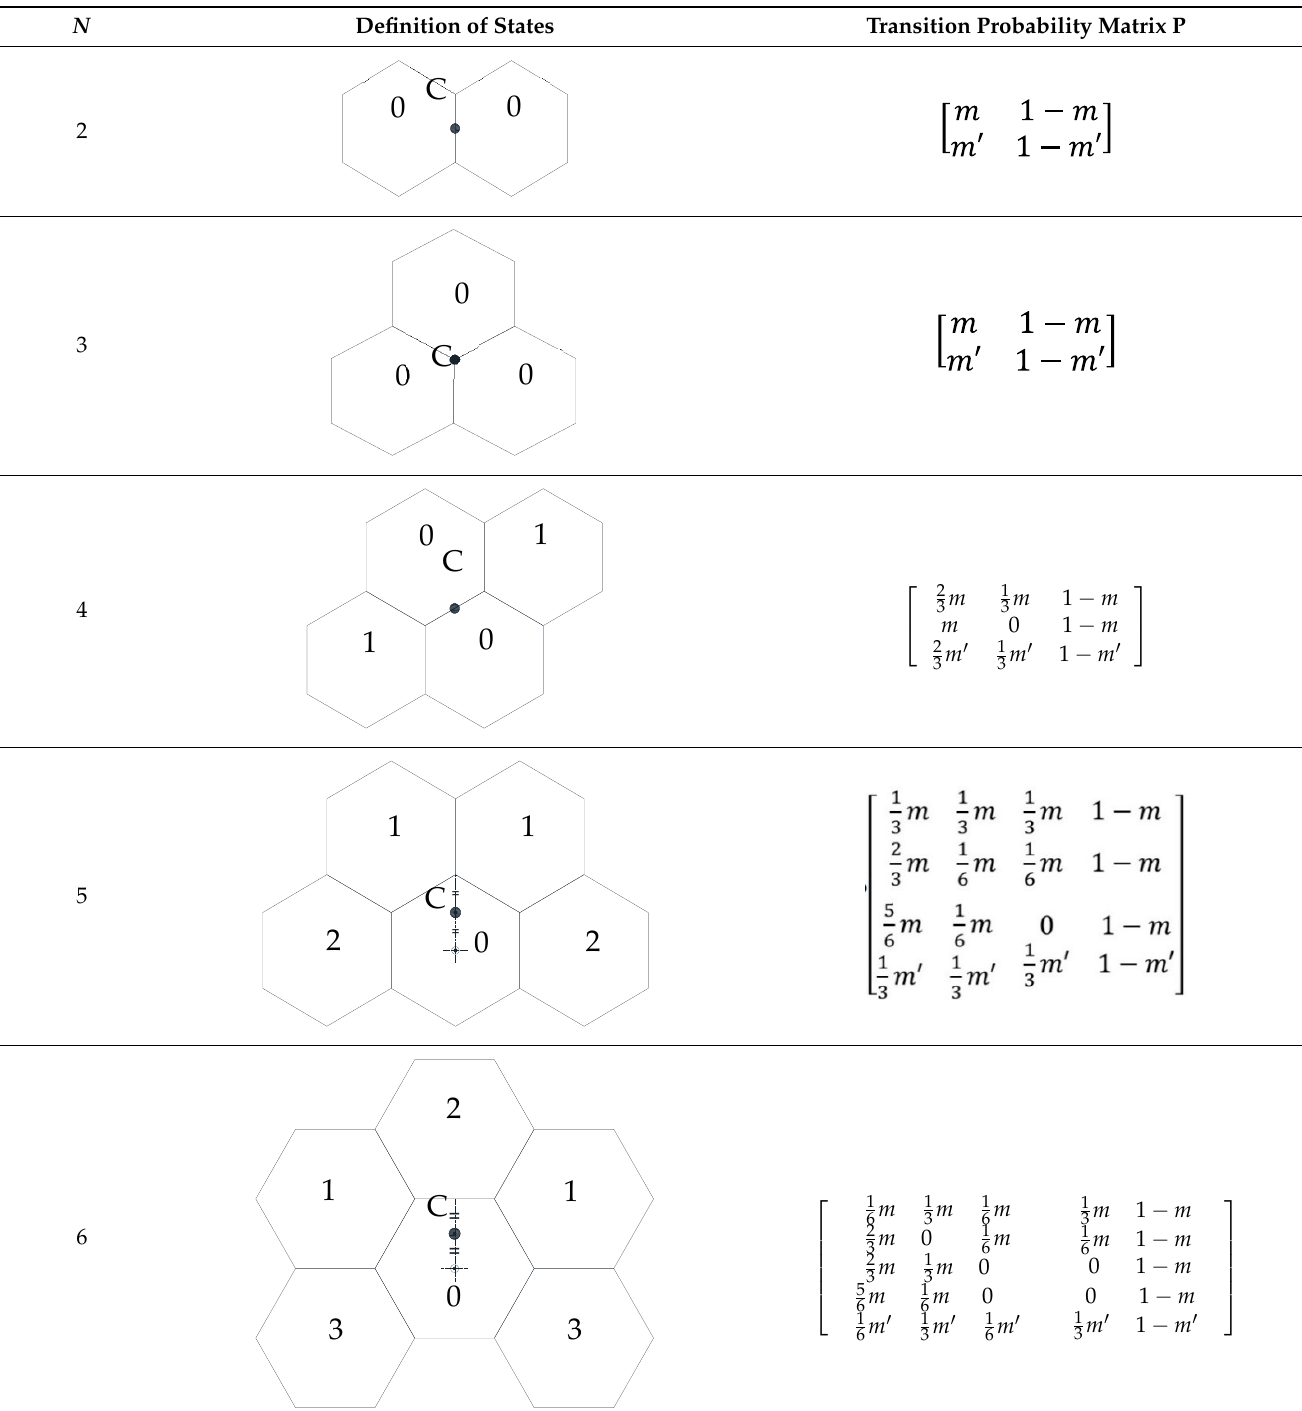
Figure 8. Transition probability matrix.